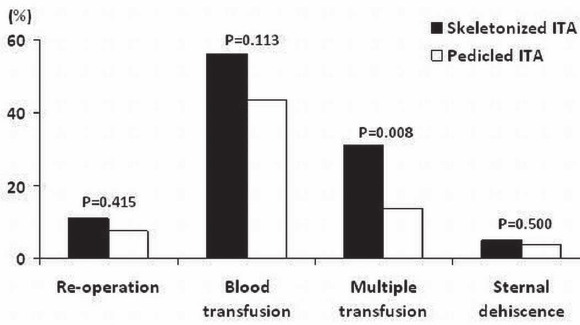
Fig. 5 – Description of postoperative complications in elderly undergoing CABG. ITA = internal thoracic artery; CABG = coronary artery bypass graft